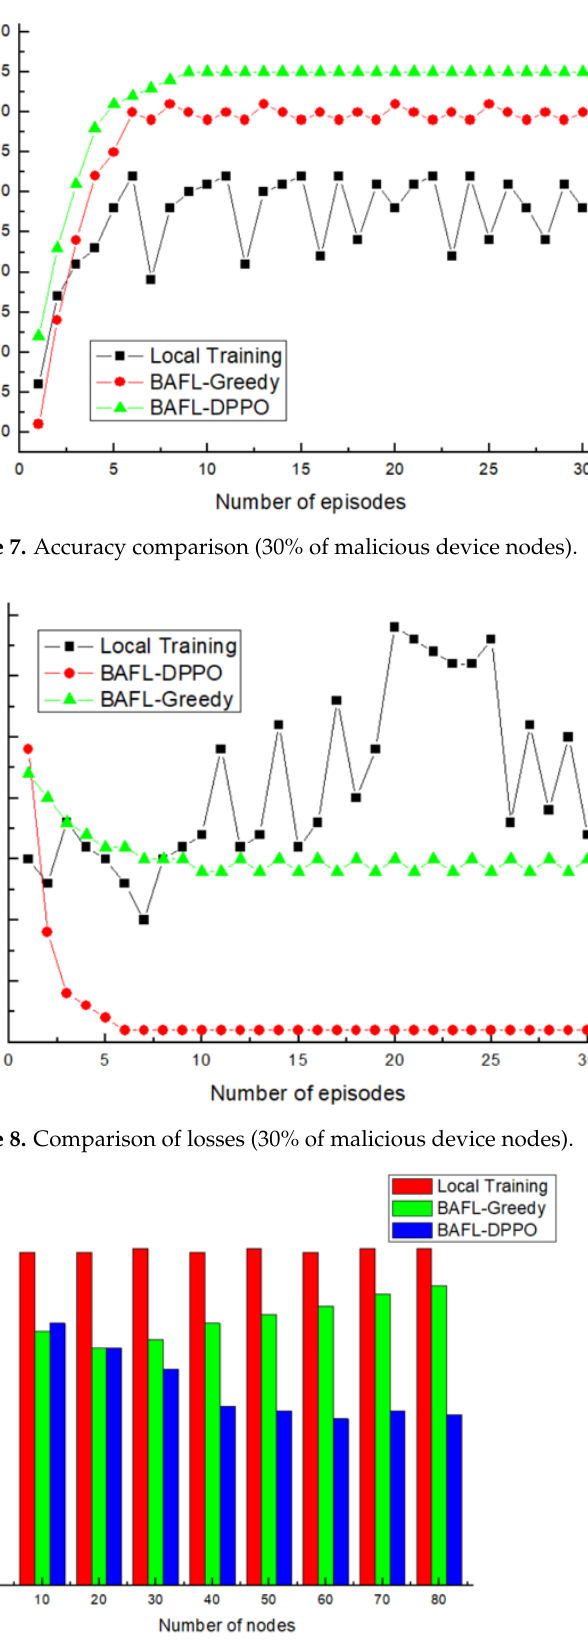
Figure 9. Latency comparison (30% of malicious device nodes).